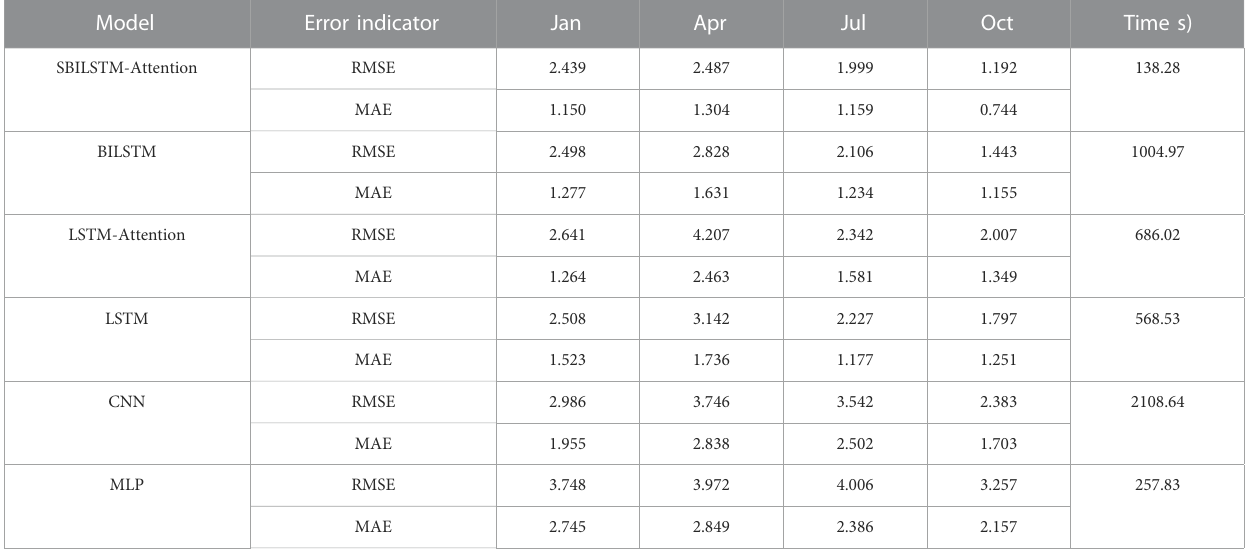
TABLE 2 Summary of error evaluation indicators.